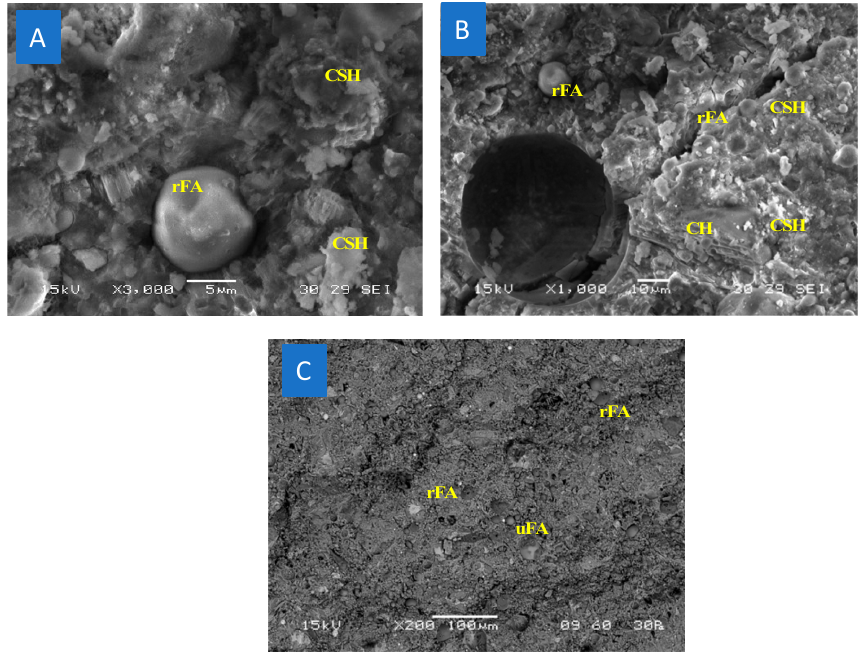
Figure 14. BSC micrograph of B7-PC60LS20FA20 28D at ( A ) 3000 × magnification, ( B ) 1000 × magnification [24] and ( C ) 100 × magnification [24]. Reproduced with permission from [24], Copyright ICE Publishing,